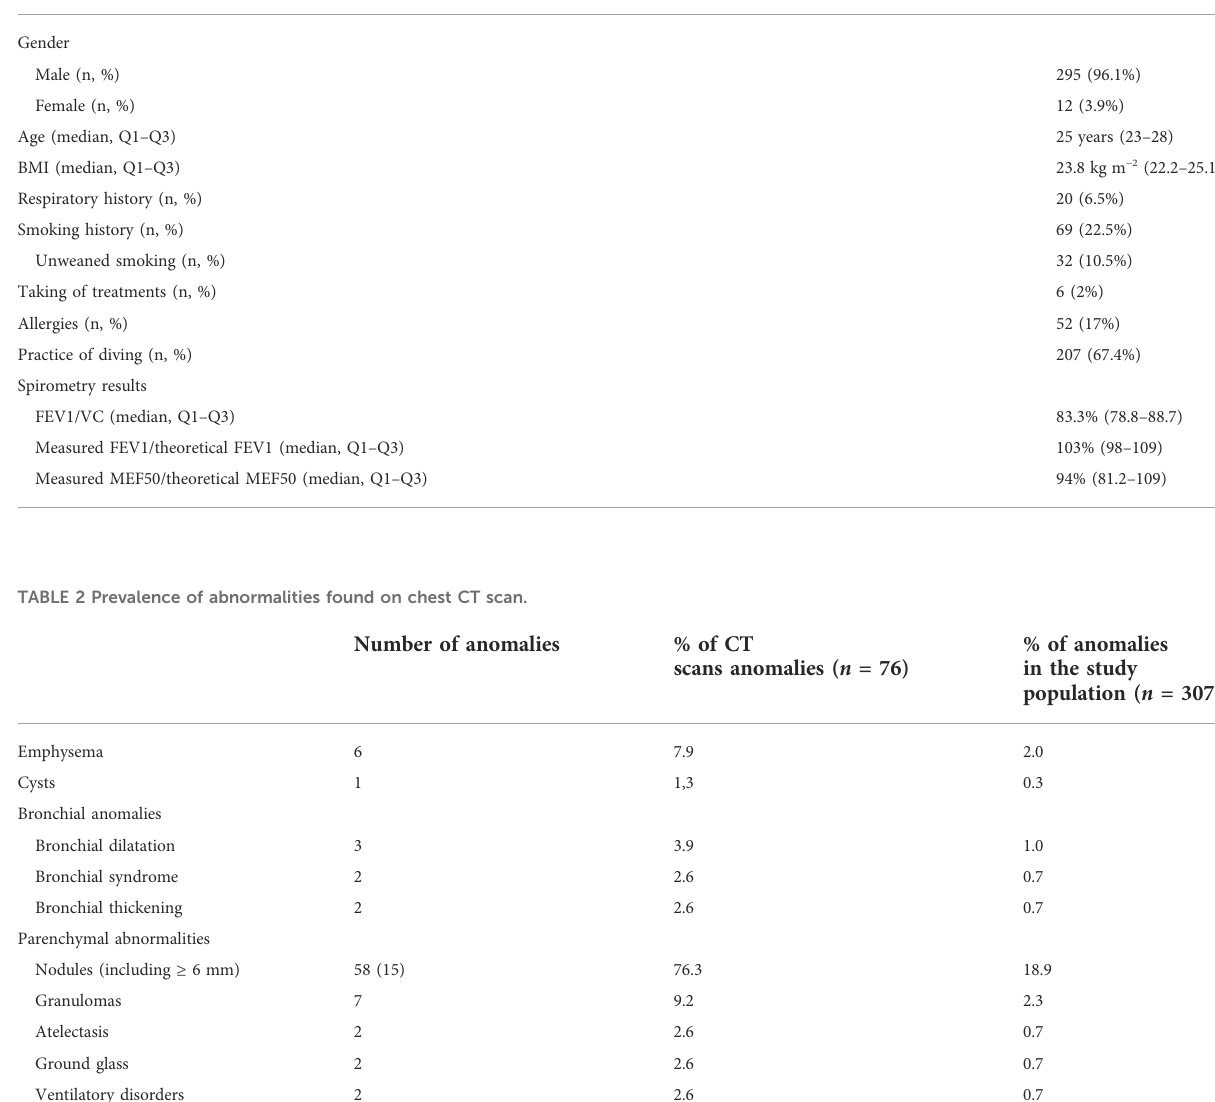
TABLE 1 Characteristics of the study population.